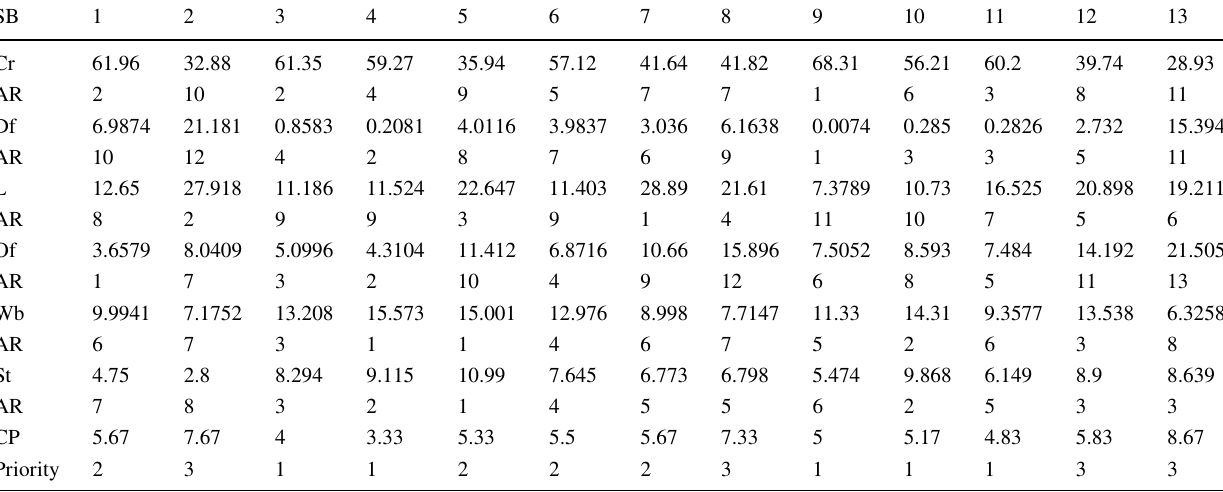
Table 8 LULC-based assigned ranking and compound value in Kansai–Kumari inter-fluvial site